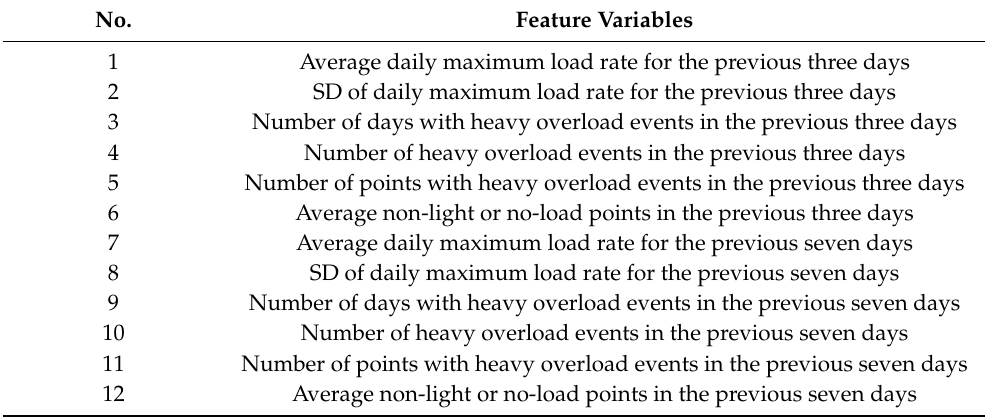
Table 4. Feature variables in the recent load